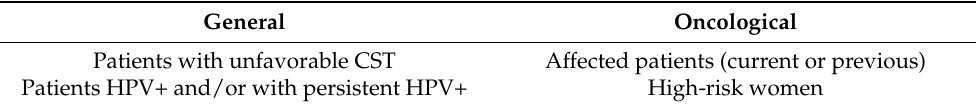
Table 3. General and oncological potential